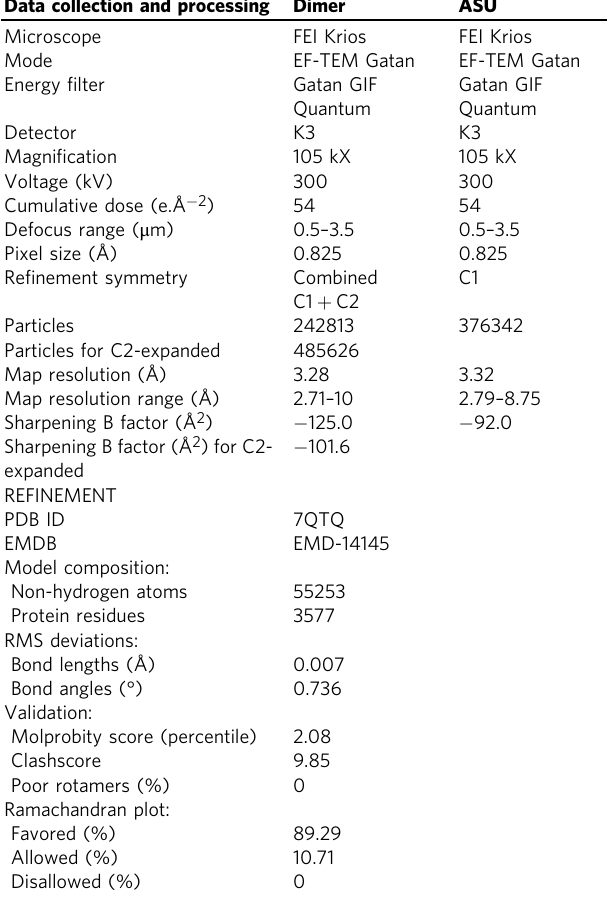
Table 1 Cryo-EM and model statistics. Data collection and processing